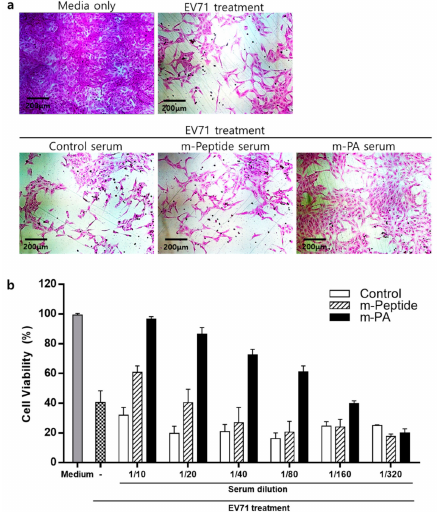
Figure 7. Serum neutralization assay. VP1 and VP3-specific antibodies can neutralize EV71 and